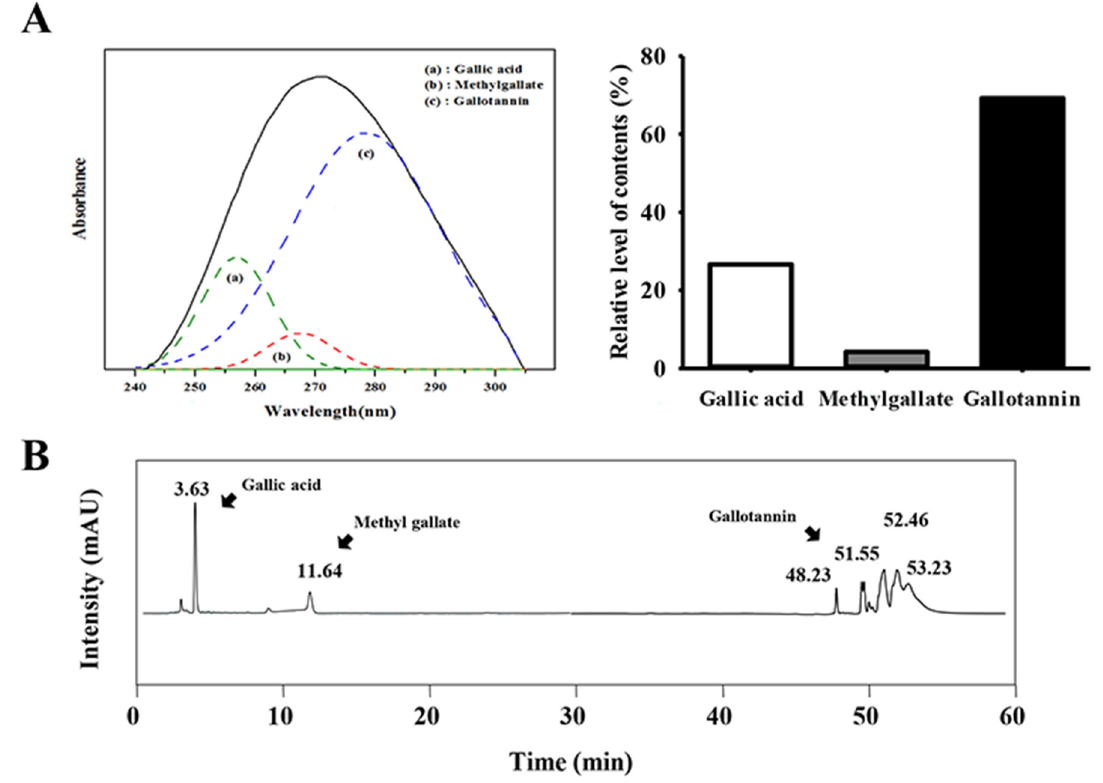
Figure 1. Analysis of major components in GEGR. The contents of gallotannin, gallic acid, and methyl gallate in GEGR were determined based on the ( A ) UV ‐ Vis spectra and ( B ) high ‐ performance liquid chromatography.